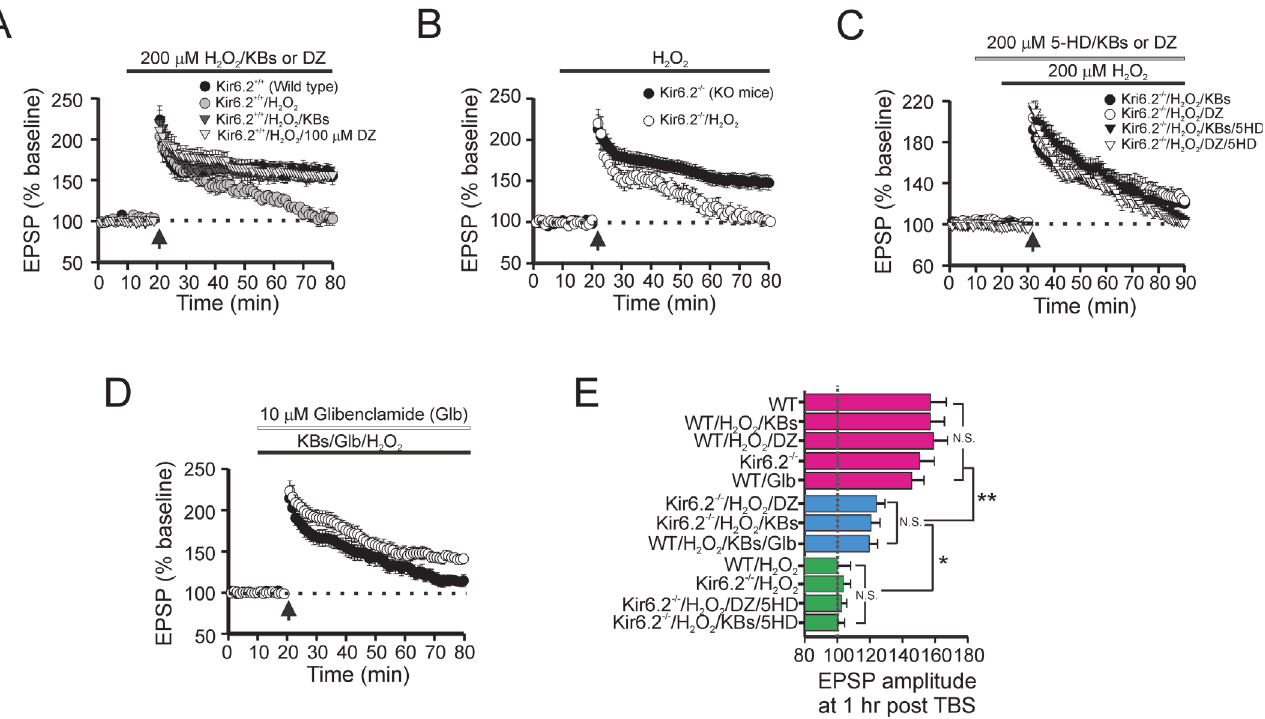
Fig 4. Both mitochondrial- and surface- K ATP channels are necessary for ketone-mediated synaptic protection. (A) TBS-evoked intact LTP in wild – type slices decayed to baseline levels 60 min after H 2 O 2 application but was maintained in slices incubated with either ketones or DZ (n = 10 slices; 5 WT mice; *** p < 0.001). (B) Loss of functional Kir6.2 channels did not affect TBS-induced LTP. However, LTP in Kir6.2 KO slices was impaired by H 2 O 2 to a basal level indistinguishable from WT slices exposed to H 2 O 2 . (C) Partial blockade of LTP in Kir6.2 KO mice. Changes in LTP from Kir6.2 KO slices were observed in the presence of either ketones (ACA and BHB, each 1 mM) or DZ (100 μ M) with H 2 O 2 (200 μ M). In contrast, addition of 5-HD in this condition resulted in the complete blockade of LTP formation (n = 8 slices from 4 KO mice). (D) Pharmacological blockade of sK ATP channels with glibenclamide (Glb; 10 μ M) did not significantly alter LTP formation, although it did produce a slight reduction in the EPSP amplitude post-TBS. When Glb was bath-applied, LTP impairment induced by